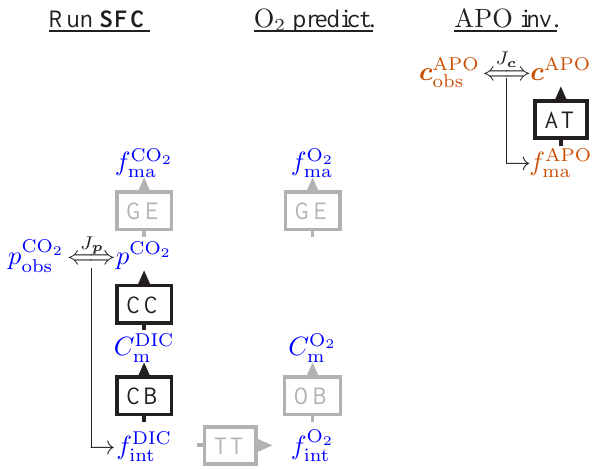
→ f DIC int Fig. 1. Illustration of the inverse procedure in our main case (run SFC ): Boxes denote the process representations causally linking quantities from bottom to top: Mixed-layer carbon budget (CB), Carbonate chemistry (CC), Solubility and sea–air gas exchange (GE). The double arrow symbolizes the matching between observed and modelled CO 2 partial pressure, as gauged by the cost function J p . The thin arrow indicates the adjustments of the unknown ocean- internal carbon sources/sinks done to minimize the model-data mis- match (see R¨odenbeck et al. (2013) for full details).